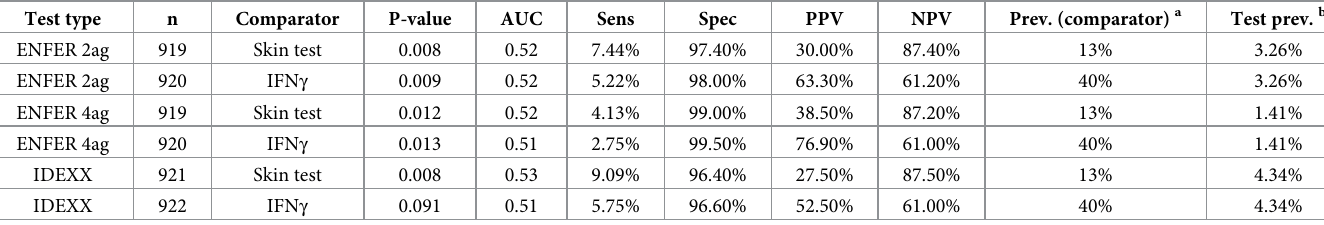
Table 1. The relative performance of serological tests against statutory ante-mortem tests. Test type